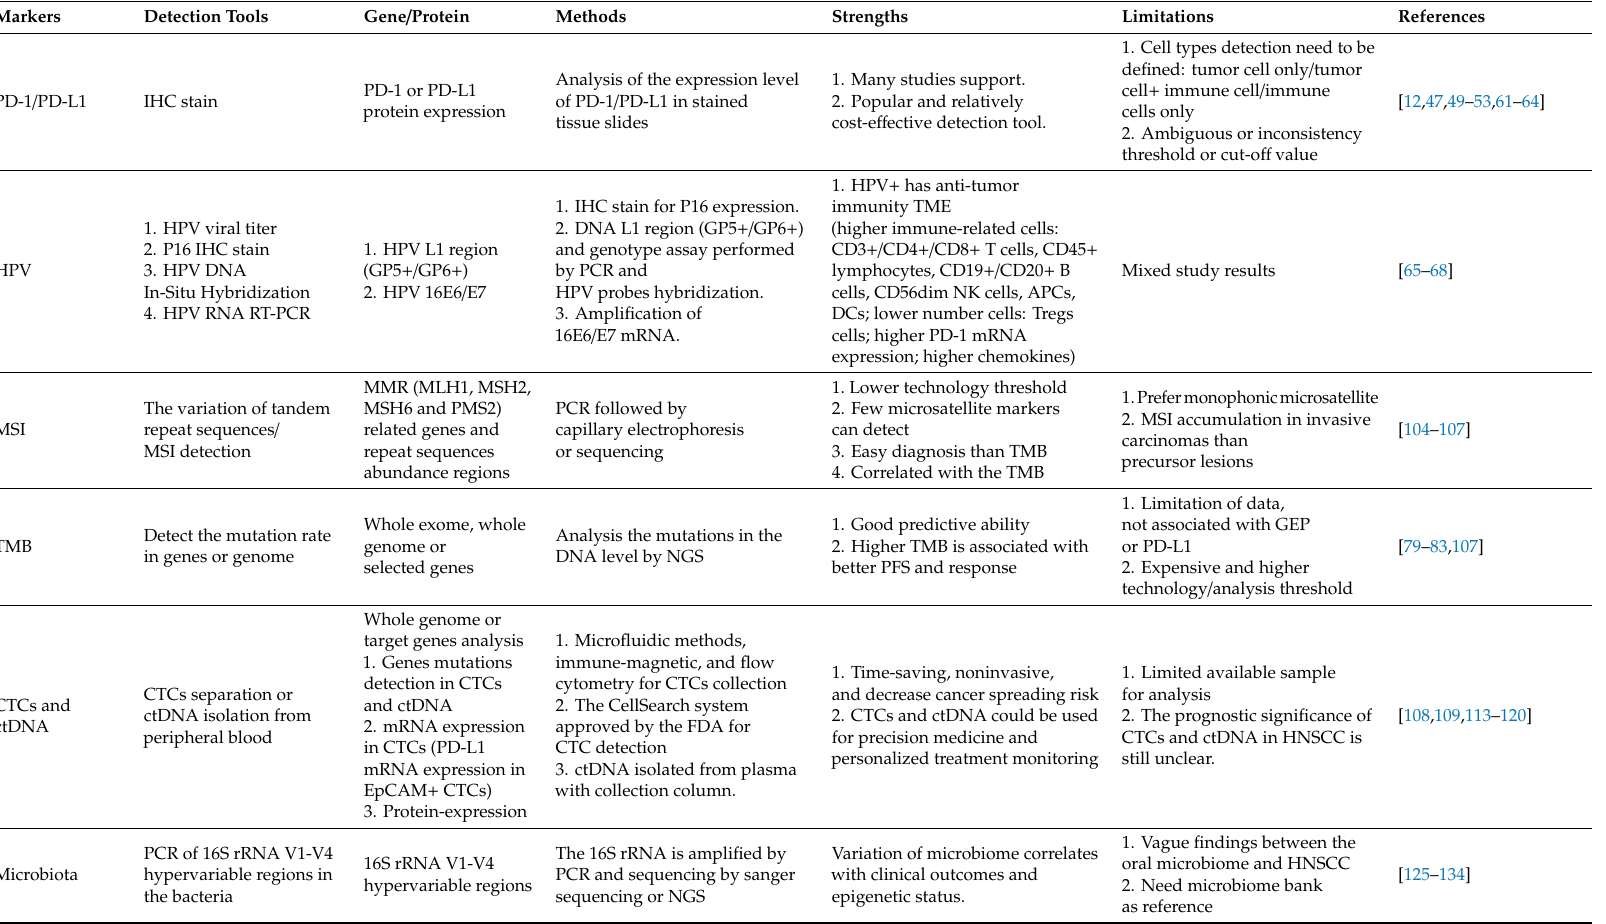
Table 3. The present diagnostic biomarkers in HNSCC: detection methods / technique, strengths, and